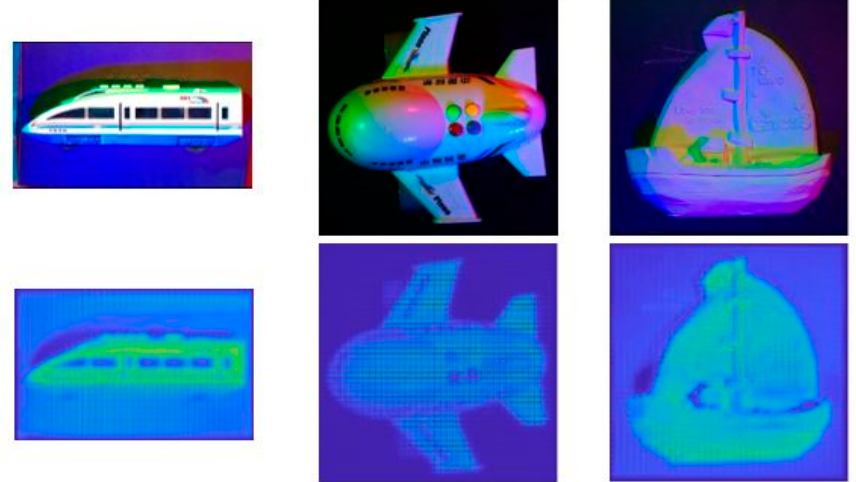
Figure 6. Results of our network with real world objects. The top line shows the input images, the bottom line shows the estimated depth result from our network respectively, which is produced by Matlab’s imagesc function.